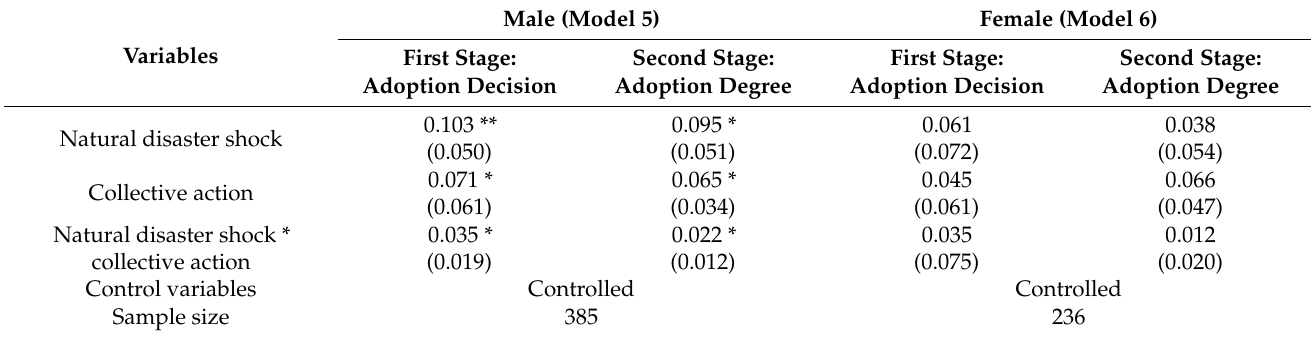
Table 8. Model estimation based on gender heterogeneity.